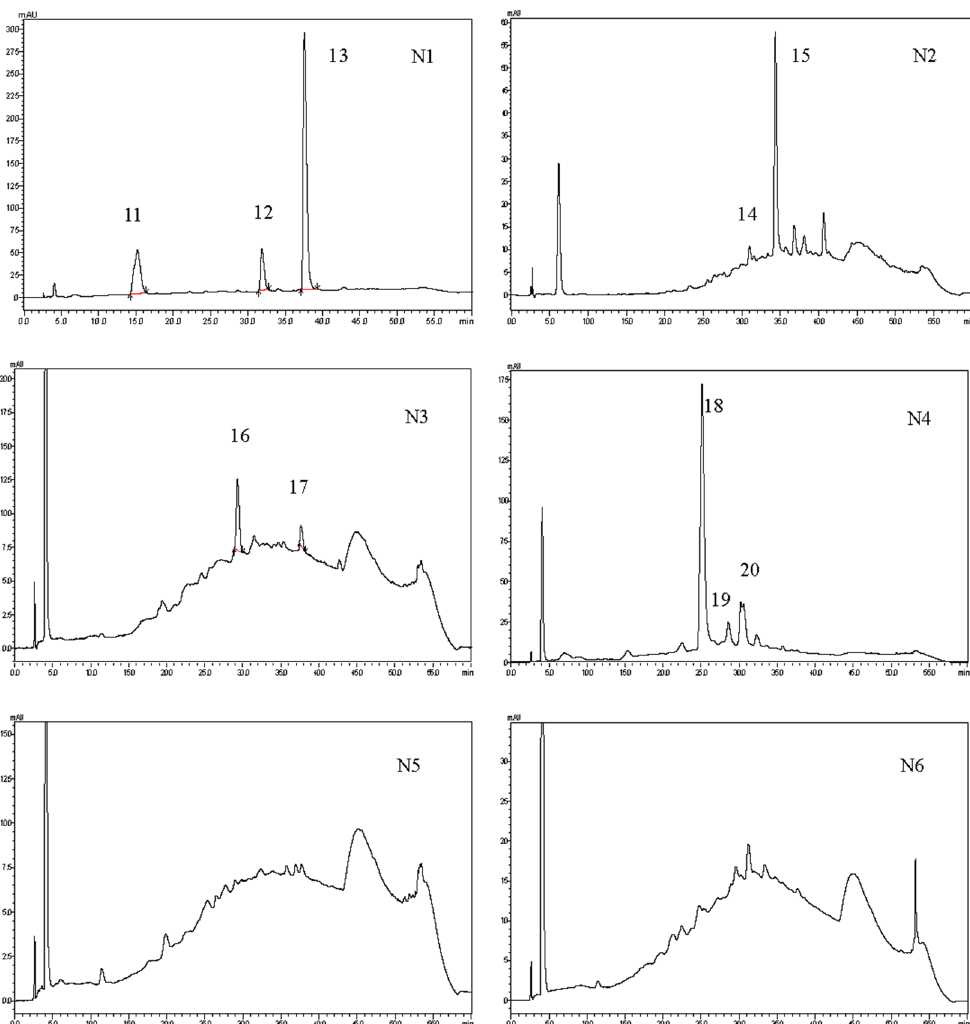
Figure 5. Reversed-phase HPLC chromatograms of fractions collected from preparative normal-phase HPLC. N1 to N6 referred to fractions collected from preparative normal-phase HPLC according to the collecting time in Table 3.